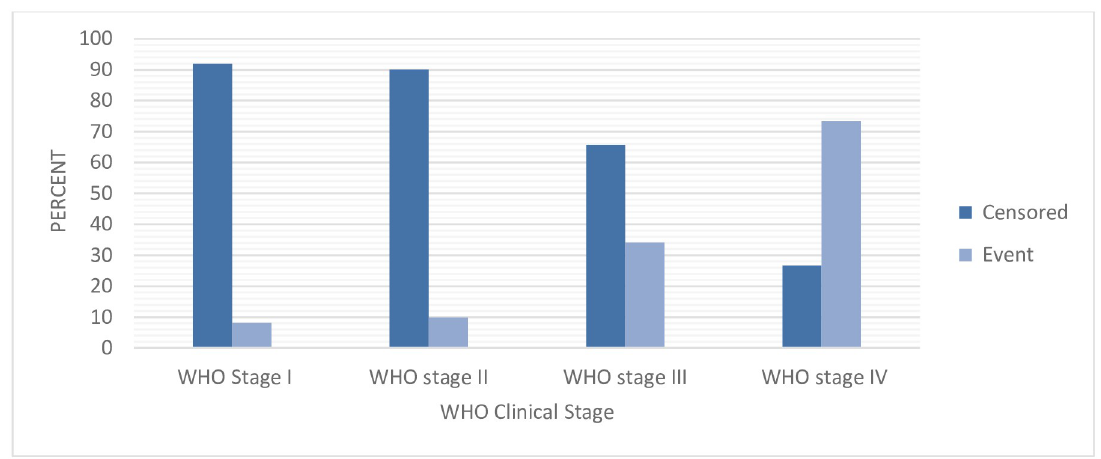
Fig 2. Distribution of ADRs by baseline WHO clinical stage among adult HIV patients on ART in public health facilities of Arba Minch town, southern Ethiopia, 2020.